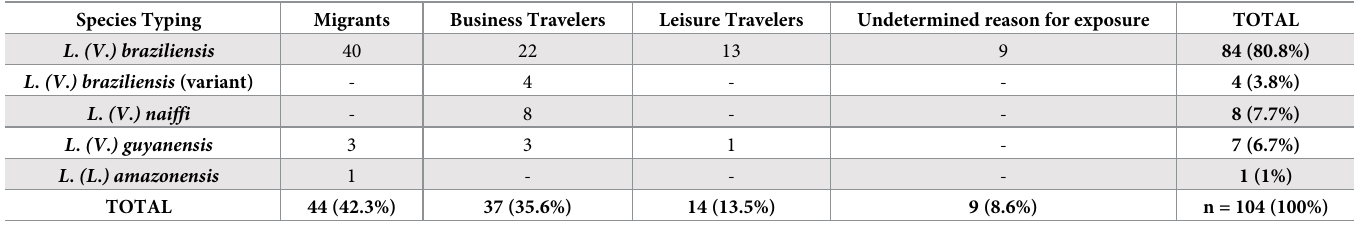
Table 2. Identification of 104 Leishmania species regarding the reason for exposure.